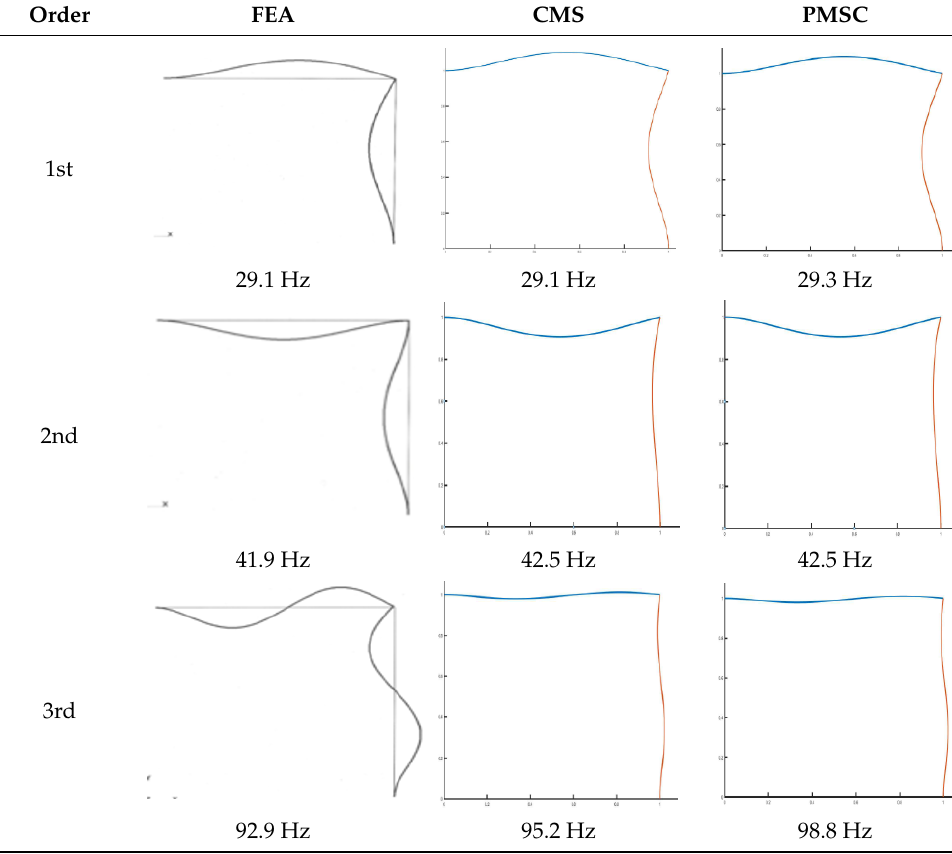
Table 10. The mode shape for each length ratio ( L A : L B = 1:1).